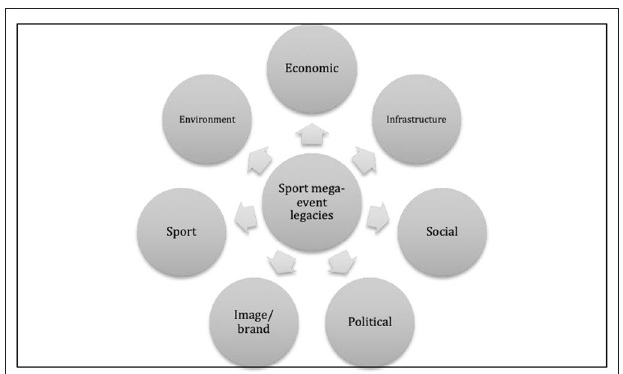
FIGURE 1 | Sport mega-event legacies (adapted by authors, from Cornelissen et al., 2011, p.